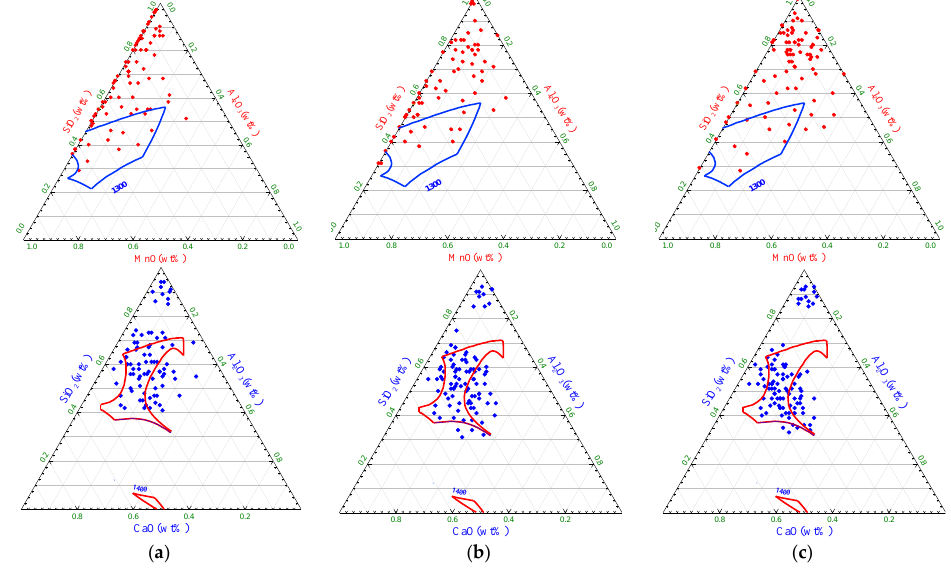
Figure 3. Inclusion distribution overlaid on phase diagram with refining time in 0 # steel sample: ( a ) 900 s (15 min); ( b ) 1800 s (30 min); ( c ) 2700 s (45 min).